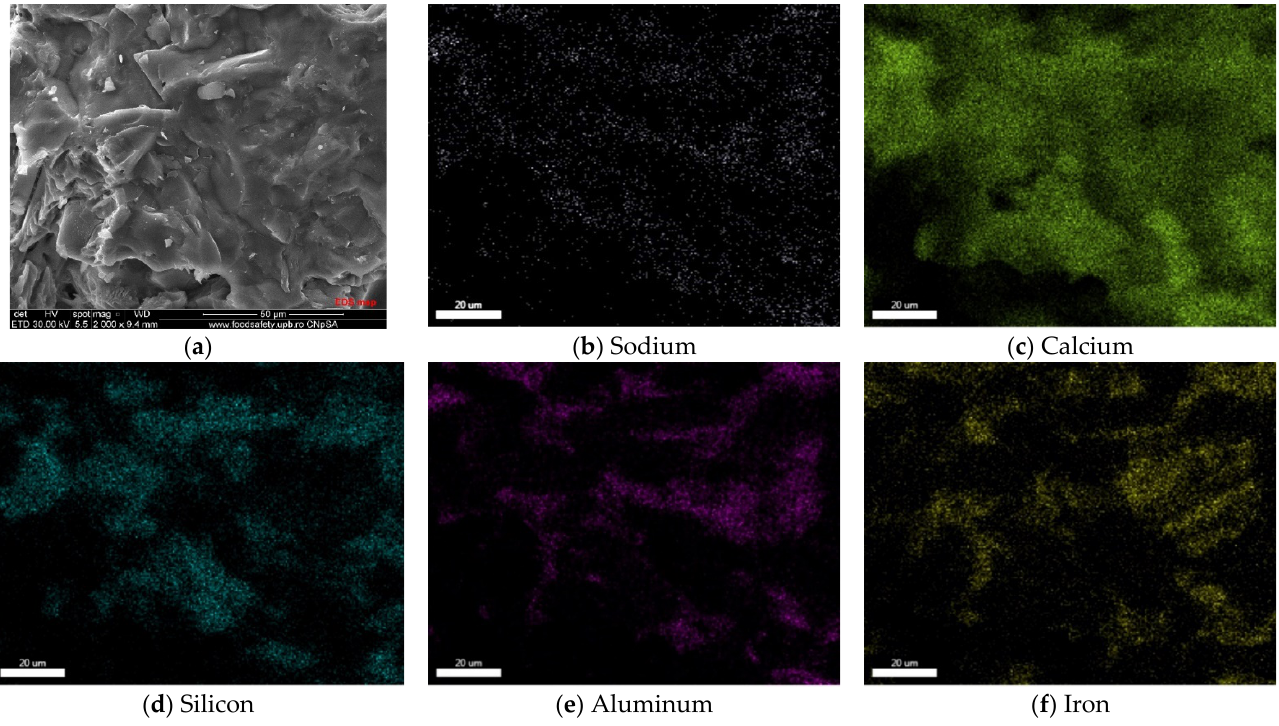
Figure 9. SEM image ( a ) and elemental mapping ( b – f ) of Gc clinker. The SEM images of clinkers obtained by the calcination of raw mixes with WG and marl are presented in Figure 10.